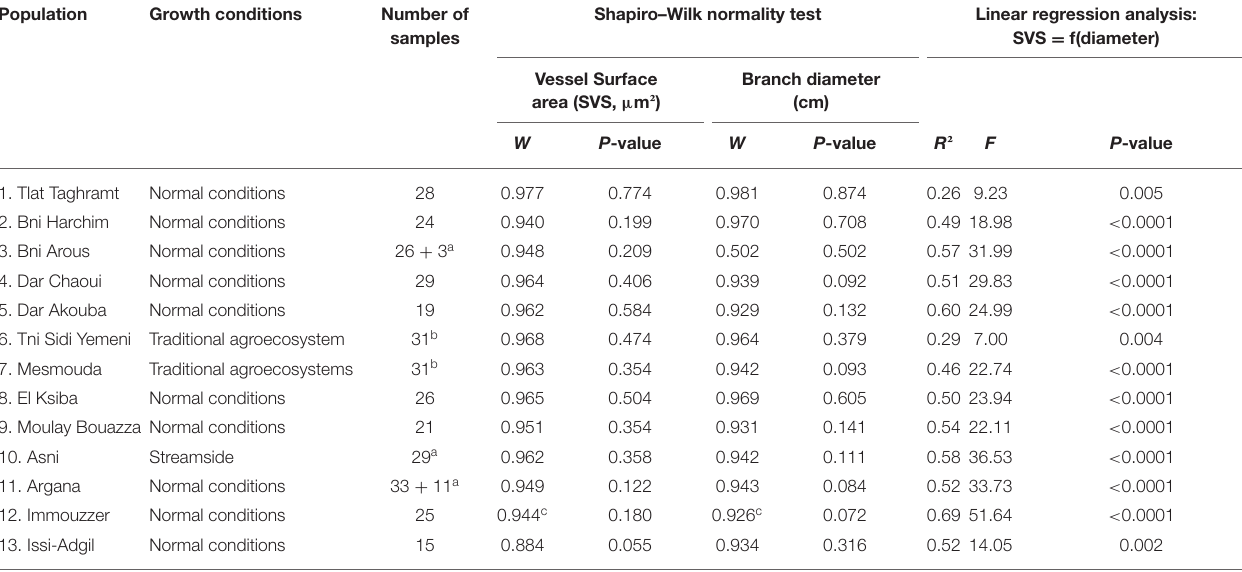
TABLE 3 | Summary of the regression analysis relating vessel surface area (SVS) and branch diameter (BD) at the intrapopulation level.